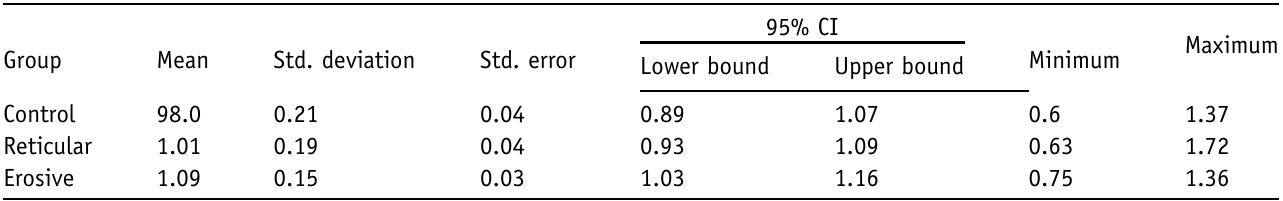
Table II. Measures of central dispersion for the depression score in the three groups ( n = 23). Group Mean Std. deviation